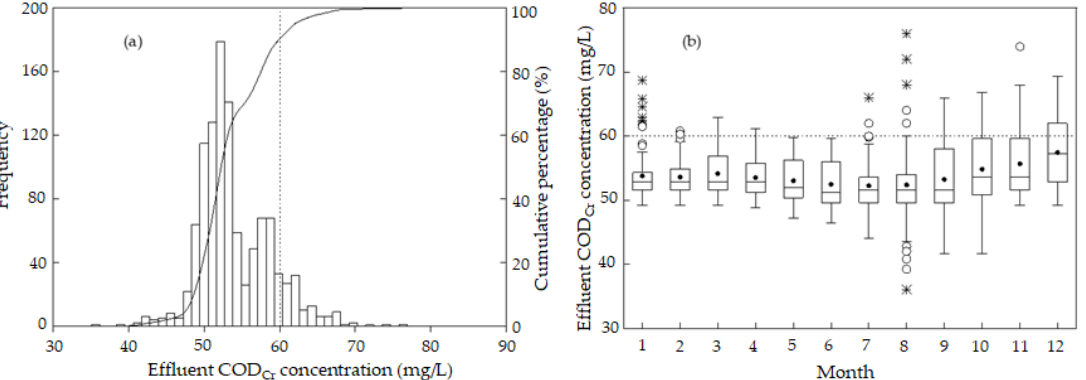
Figure 5. ( a ) Probability distribution and ( b ) monthly distribution of effluent COD Cr . The solid circle (•) represents the average. Outliers are marked by a hollow point (°) and extreme points are marked by an asterisk (*).